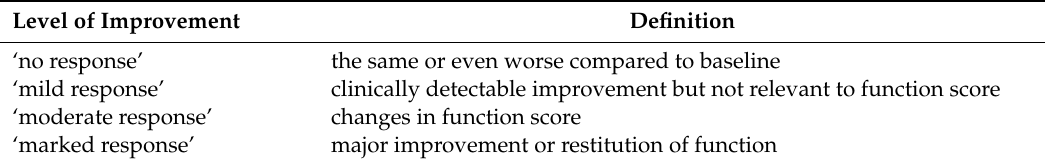
Table 1. Classification of treatment response in the reviewed literature.